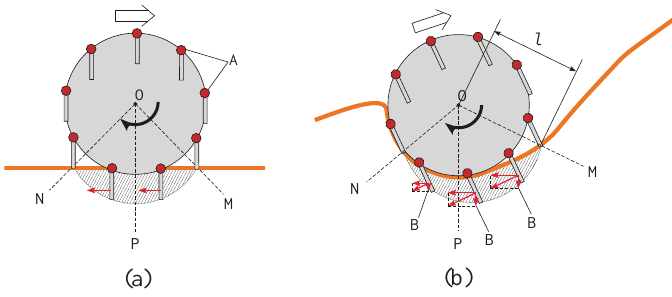
Figure 2. Grouser at a constant angle: ( a ) On a level incline; ( b ) On a steep incline.